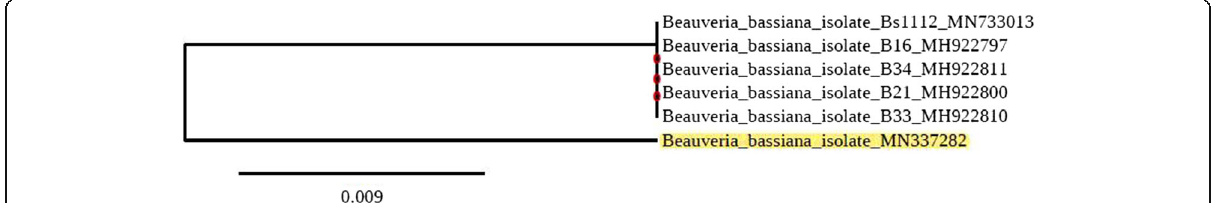
Fig. 1 Maximum likelihood ITS phylogenetic trees of Beauveria bassiana species using ITS sequence. Based on nucleotide sequences of isolated Beauveria bassiana (highlighted) and reference strains with their accession no.(alignment length approximately ~532 bp using phylo_tree analysis (Phylogeny.fr. program))